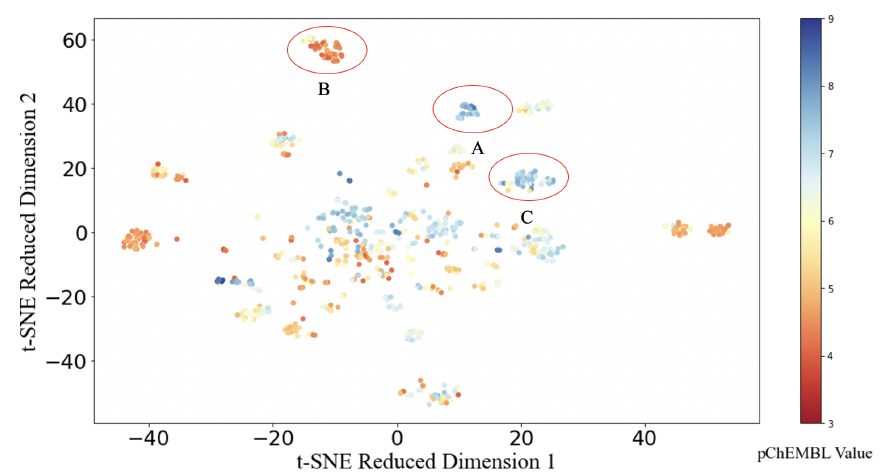
Figure 2. Dimensionality reduction by t-distributed Stochastic Neighbour Embedding (t-SNE) on fingerprint bit vectors. The colourbar indicates pChEMBL values from 3 (red) to 9 (blue).